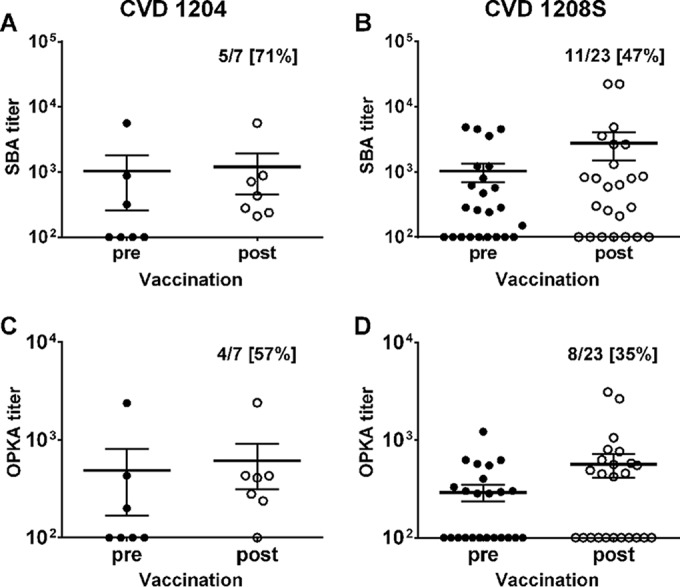
SBA and OPKA antibody responses induced by oral vaccination with live attenuated S. flexneri 2a vaccines. SBA (A and B) and OPKA (C and D) titers in serum samples from adult U.S. volunteers orally immunized with 107 CFU of CVD 1204 (n = 7) or CVD 1208S (n = 23) vaccine strains before and 28 days after vaccination. The numbers in the upper right of each graph are the number of subjects that seroconverted over the total number of subjects, with the percent seroconversion shown in brackets.